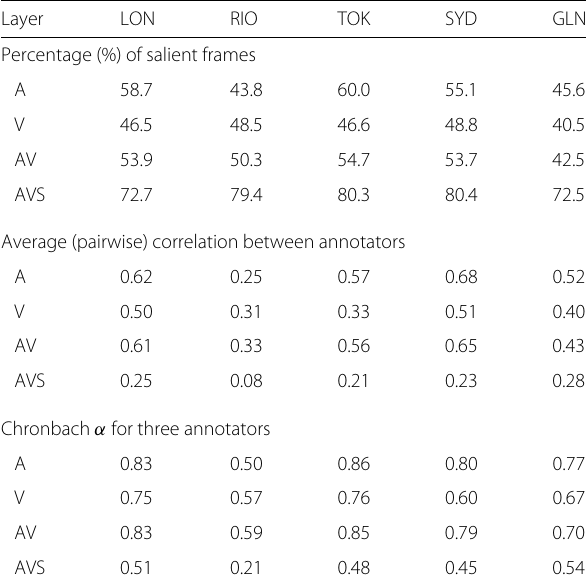
Table 3 Statistics for COGNIMUSE database (travel documentaries) annotated with salient events